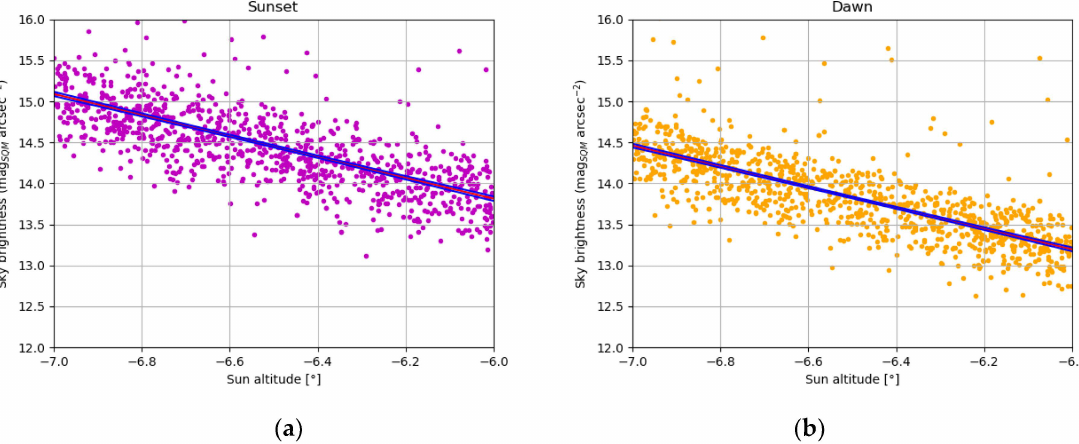
Figure 3. Recorded data corresponding to all sunsets ( a ) and all dawn ( b ) at Pennar